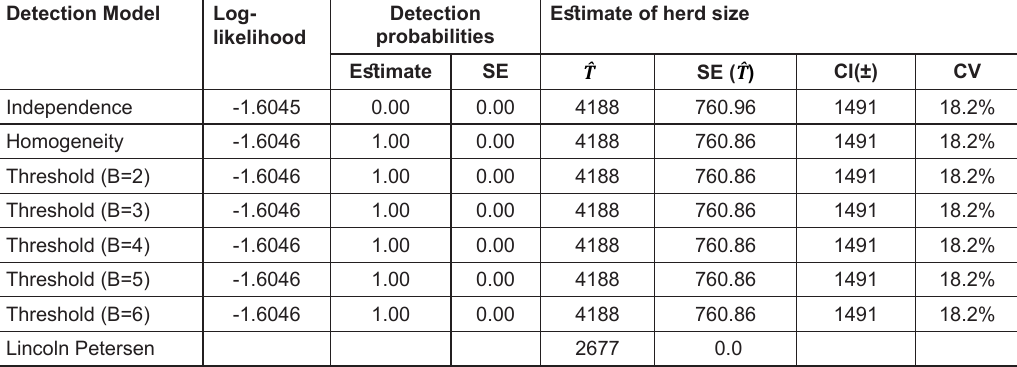
Table 37. Rivest Estimator results and LP estimate for the Tuktoyaktuk Peninsula herd on July 9,